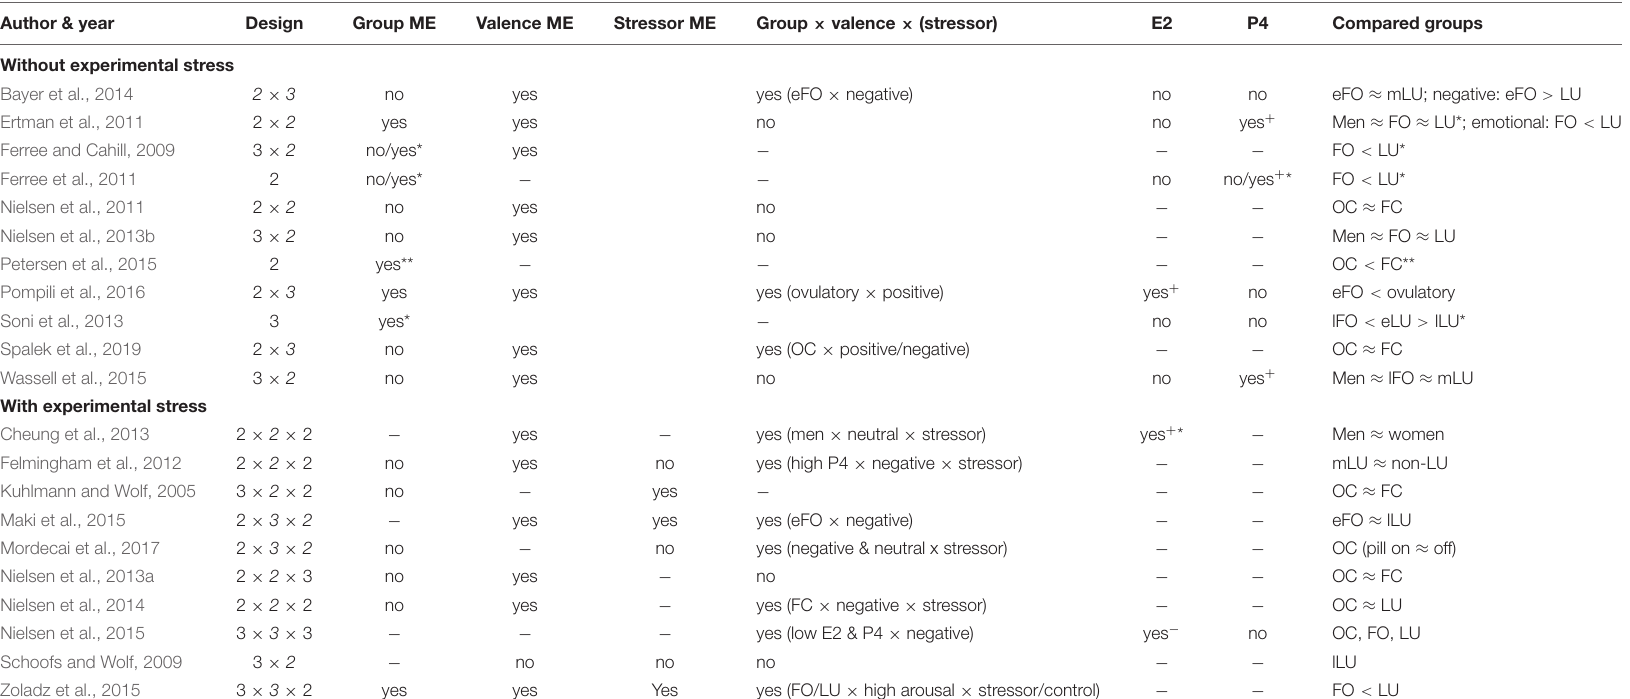
TABLE 3 | Emotional memory in hormone-status groups: Design and